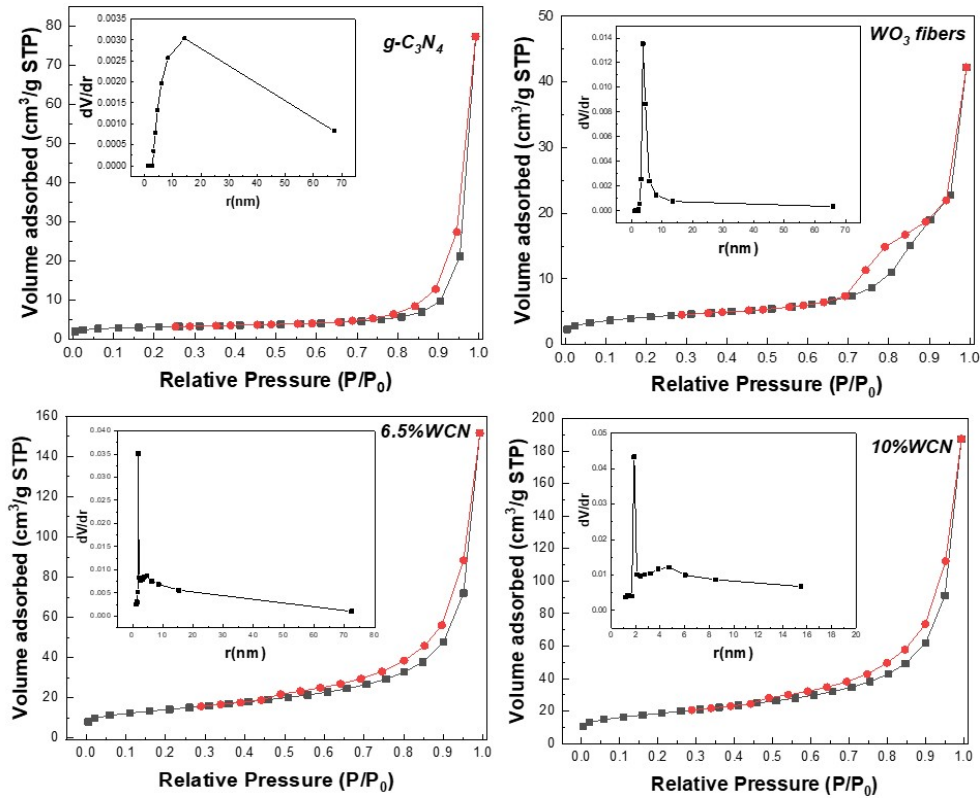
Figure 4. Nitrogen adsorption-desorption isotherms and pore size distributions for the prepared g-C 3 N 4 , 5%WCN, 6.5%WCN and 10%WCN. Table 1. Physicochemical properties of prepared catalysts.